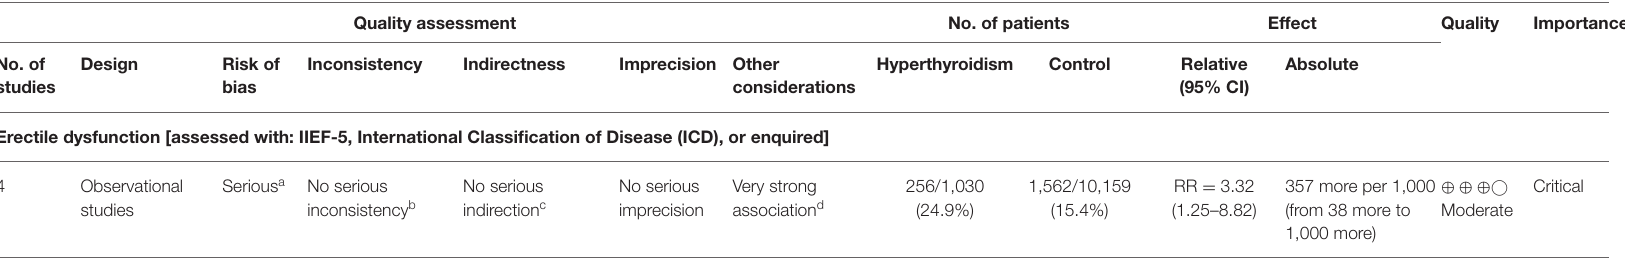
TABLE 2 | GRADE-profiler summary of evidence for the effects of stroke and erectile